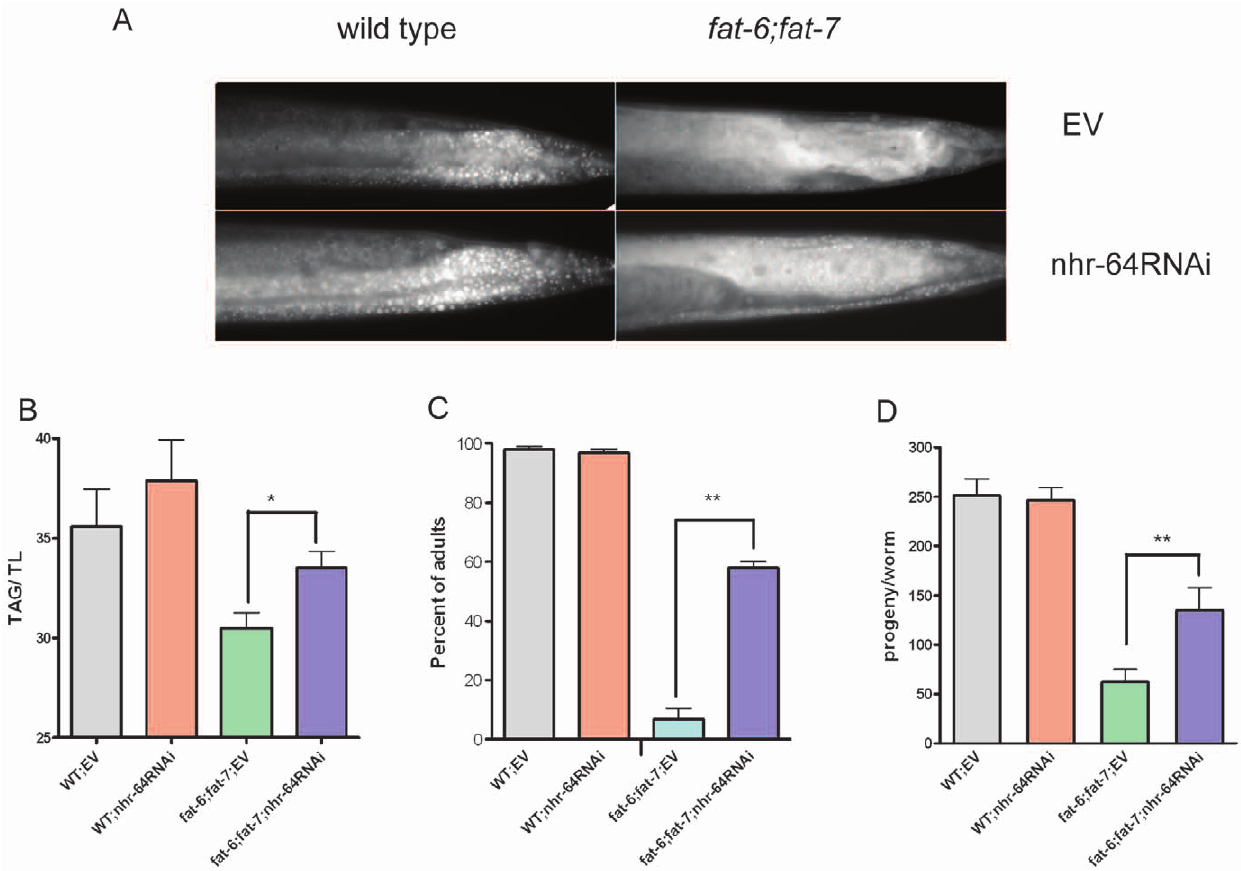
Figure 1. Inactivation of nhr-64 by RNAi increases fat stores, growth rate, and brood size of fat-6;fat-7 double mutants grown on E. coli strain HT115. Values determined to be significantly different from worms treated with empty vector, *P , 0.05, **P , 0.01. (A) Inactivation of nhr- 64 increased Nile Red staining of fixed wild type and fat-6;fat-7 double mutants. Images were captured at using identical settings and exposure time for each image. Animals shown are young adults. Anterior is left, posterior is right. (B) Inactivation of nhr-64 increased the triacylglycerol/total lipid (TAG/TL) ratio in fat-6;fat-7 double mutants. Total lipids were extracted from three independent biological replicates and separated into triacylglycerol and phospholipid fractions using thin layer chromatography and quantified using gas chromatography. Error bars are standard deviation. (C) Improved the growth rate of fat-6;fat-7 double mutants treated with nhr-64RNAi and empty vector control (EV). The graph shows the percentage of animals that reached adult stage 72 h after plating synchronized L1 larvae onto RNAi plates seeded with E. coli strain HT115 carrying empty vector (EV) or nhr-64RNAi . The experiment was repeated twice, each time using 100-150 animals. Error bars show the range of the two experiments. (D) Inactivation of nhr-64 led to increased brood size in fat-6;fat-7 double mutants. The number of progeny produced by individual fat- 6;fat-7 and wild-type animals treated with either empty vector (EV) or nhr-64RNAi was counted. Data shown are the average brood size of 10–15 individuals. Error bars are standard error. doi:10.1371/journal.pone.0009869.g001 including levels of unusual polyunsaturated fatty acids produced Two nhr-64 deletion mutations produce truncated NHR- by fat-6;fat-7 double mutants [23] did not change. 64 with residual transcriptional activity Given the importance of C15iso and C17iso in the regulation of To confirm the suppression of fat-6;fat-7 double mutants by growth and development in C. elegans [24,25], as well as the fact that inactivation of nhr-64 , we examined two available nhr-64 deletion fat-6;fat-7 and sbp-1 mutants have low levels of C15iso and C17iso mutants, ok1957 and tm1106 . Both nhr-64(ok1957) and nhr- [23,24], we suspected that improved growth and higher fat stores of 64(tm1106) mutants appear similar to wild type, with no obvious fat-6;fat-7 double mutants treated with nhr-64RNAi might be a changes in growth rate, brood size, and fat storage. The only consequence of increased levels of C15iso and C17iso. However, phenotype shared by the deletion mutants and the nhr-64RNAi dietary supplementation with a range of concentrations of C15iso, were specific fatty acid composition changes, most notably the C17iso, or a combination of both fatty acids did not improve growth higher levels of C15iso and C17iso fatty acids (Figure S2A). We rate or fat stores of fat-6;fat-7 double mutants, even though the generated both nhr-64;fat-6;fat-7 triple mutant strains and found dietary supplementation successfully increased the levels of C15iso that, growing on E. coli OP50, neither deletion mutant was able to and C17iso in the worms (data not shown). Alternatively, optimal suppress the fat storage and growth defects in fat-6;fat-7 double levels of stearic acid (18:0) may be critical for proper fat storage, mutants. In fact, the triple mutant strains were indistinguishable growth, and reproduction [10]. We found that the decrease in 18:0 from the fat-6;fat-7 double mutants with respect to fat stores, correlates with improved growth and increased fat storage in the fat- growth rate, and brood size. The triple mutants did contain higher 6;fat-7 and sbp-1 mutants treated with nhr-64(RNAi) . C15iso and C17iso levels than fat-6;fat-7 , but only a slight